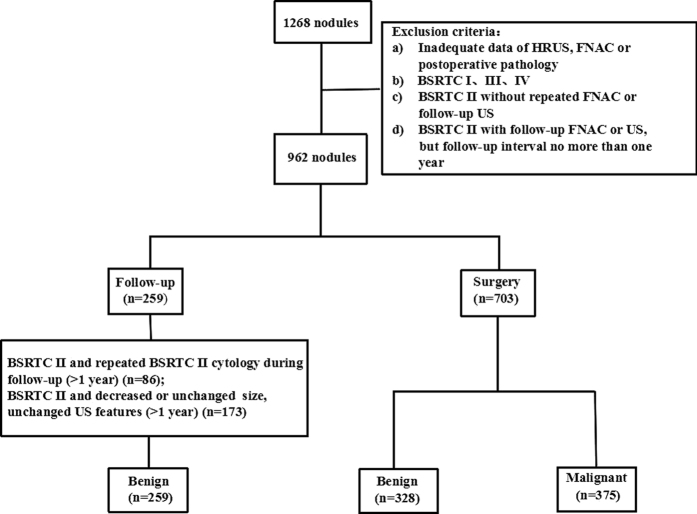
Diagram of the study group.